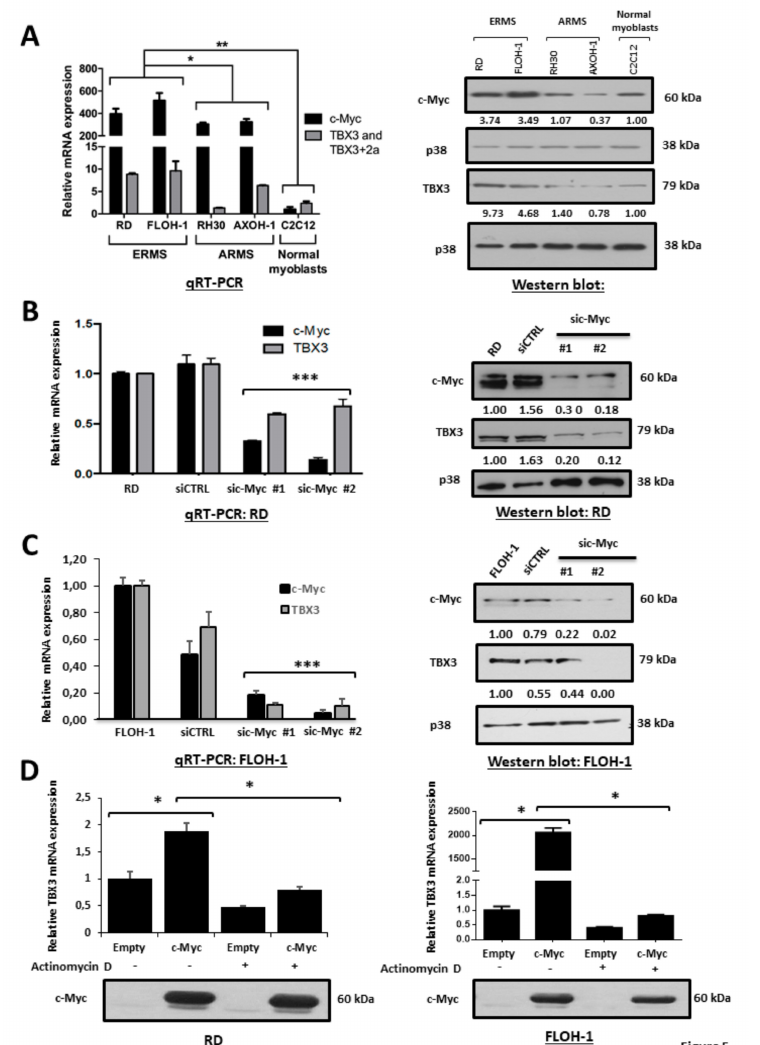
Figure 5. c-Myc transcriptionally upregulates TBX3 in ERMS. ( A ) Total RNA and protein were extracted from the indicated RMS cell lines and normal muscle myoblasts (C2C12) and (left) qRT-PCR was performed on reverse transcribed RNA using primers specific to c-Myc, TBX3, TBX3 + 2a and either GUSB or β -Actin (housekeeping genes). mRNA levels for c-MYC were normalised to β -Actin and mRNA levels for the two TBX3 isoforms were normalised to GUSB and the results were quantified relative to the results obtained for C2C12. (Right) protein extracts (the same used in Figure 1A) were subjected to Western blot analysis with antibodies specific to c-Myc, TBX3 (same blot as shown in Figure 1A) and p38 (loading control). ( B ) RD and ( C ) FLOH-1 cells were transiently transfected with 50 nM siRNAs to c-Myc (sic-Myc#1 and sic-Myc#2) or control siRNA (siCTRL) for 48 h. Extracts were subjected to (left) qRT-PCR and (right) Western blot analyses using primers or antibodies to c-Myc and TBX3 respectively. Densitometric readings for all Western blots were calculated relative to the p38 control. ( D ) RD and FLOH-1 cells were transfected for 48 h with 500 ng pcDNA-Flag-c-Myc or pcDNA-Flag-Empty expression constructs, then treated with 5 µ g / mL Actinomycin D or vehicle (DMSO) for 30 min. (Upper) qRT-PCR was performed on reverse-transcribed RNA using primers to TBX3 and mRNA levels were normalized to β -Actin. The values in the graphs represent the mean of three independent experiments ± SEM (* p < 0.05; ** p < 0.001; *** p < 0.001). (Lower) protein extracts were subjected to Western blot analysis with an antibody specific to